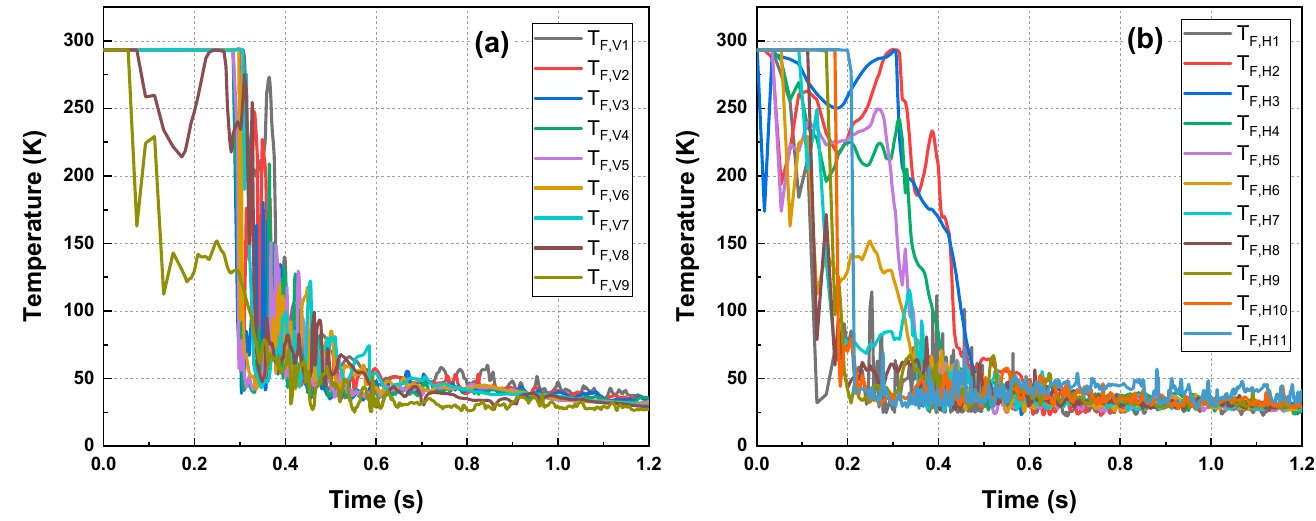
Figure 13. Variations in ( a ) the vertical fluid temperature and ( b ) horizontal fluid temperature according to charging process.